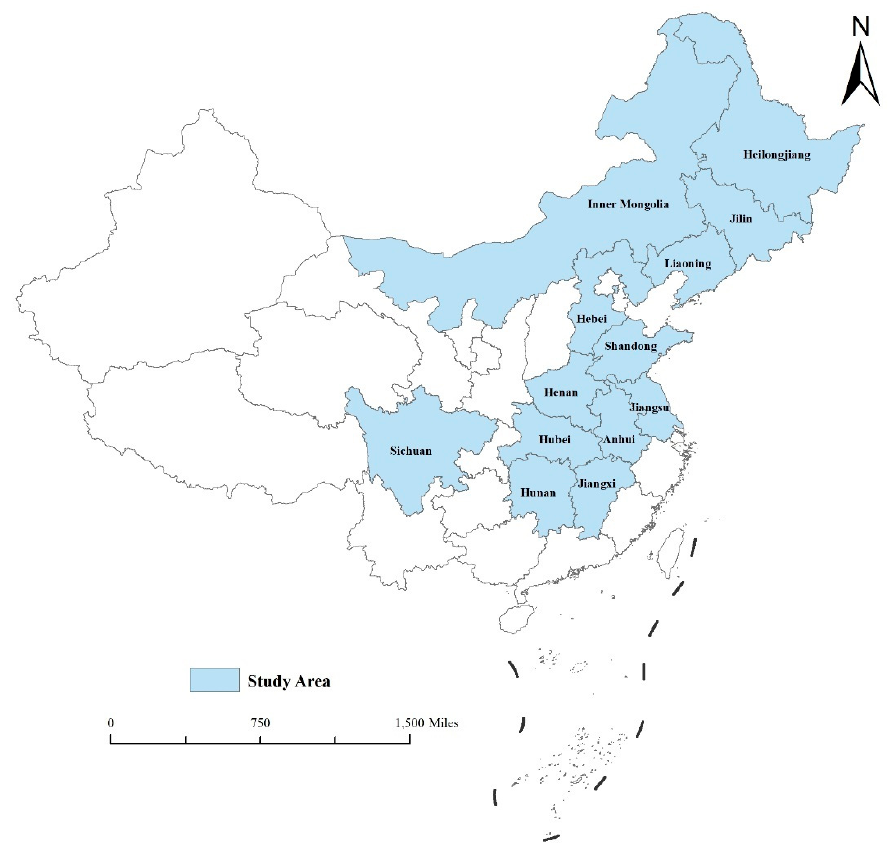
Figure 1. Location of the study area.